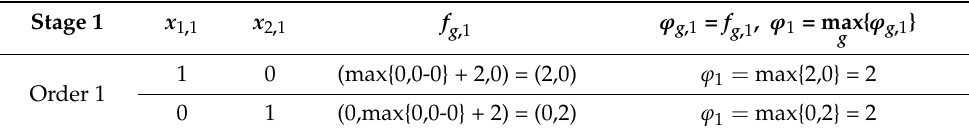
Table 2. Results of the first algorithm stage